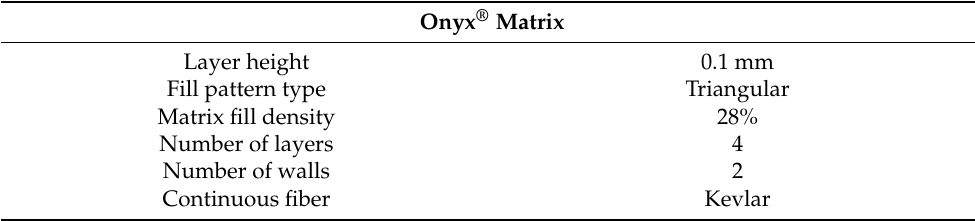
Table 2. Matrix printing parameters for the composite material, from